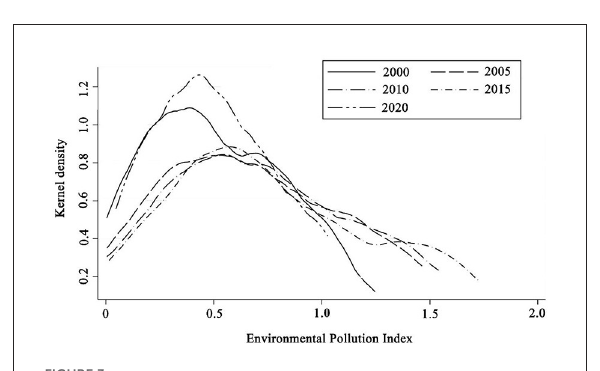
FIGURE3 Dynamic evolution of the national EP from 2000 to